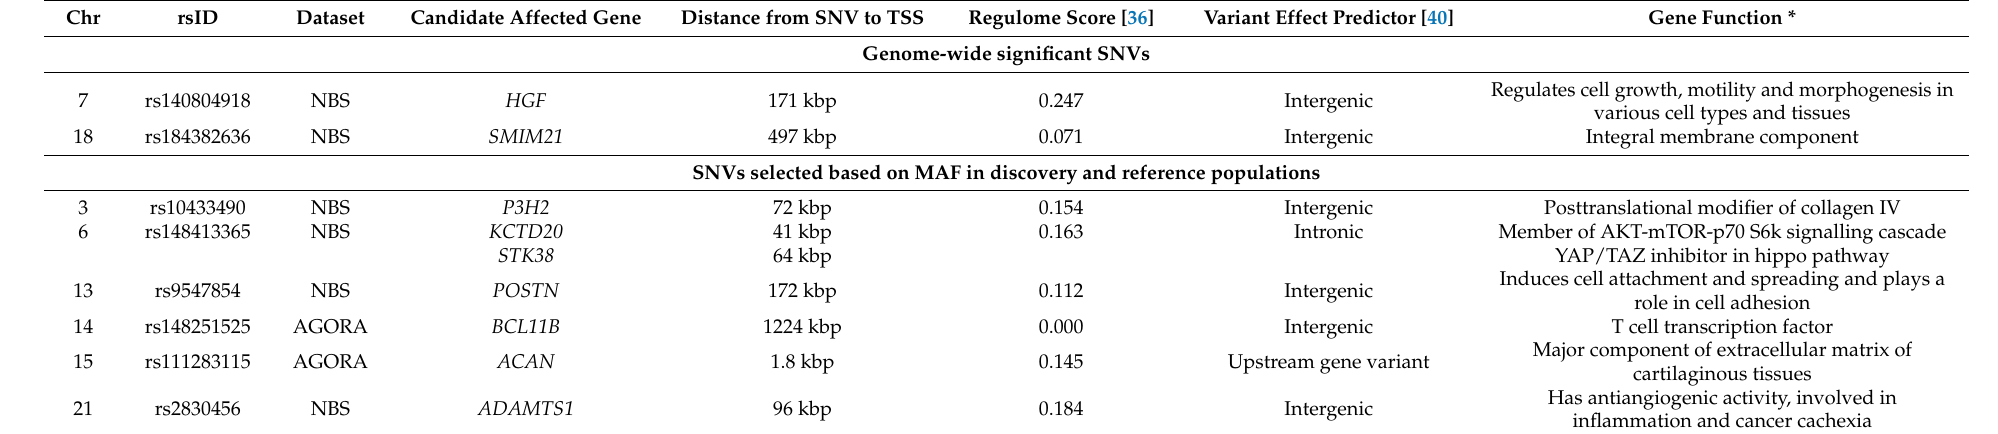
Table 2. A selection of genomic risk loci with candidate affected protein-coding